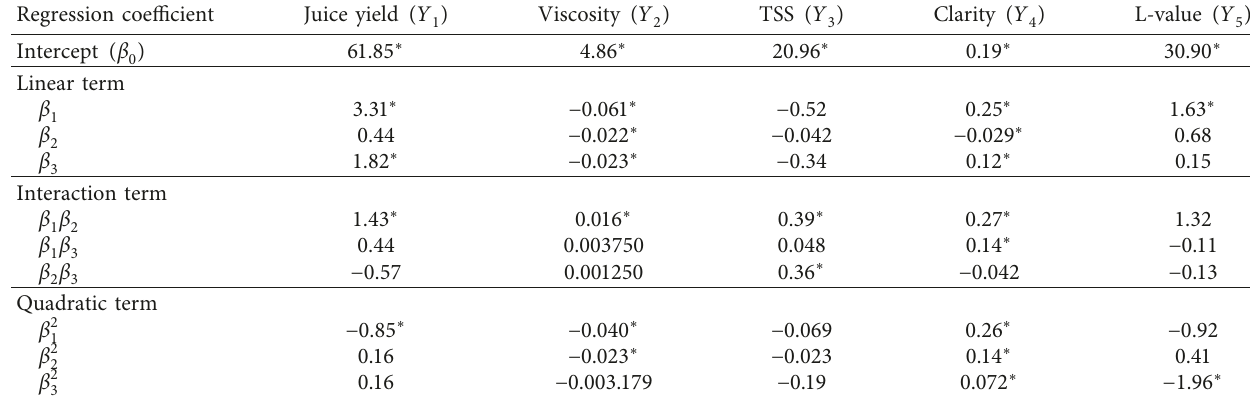
Table 3: Regression coefficient for each response under suggested models.